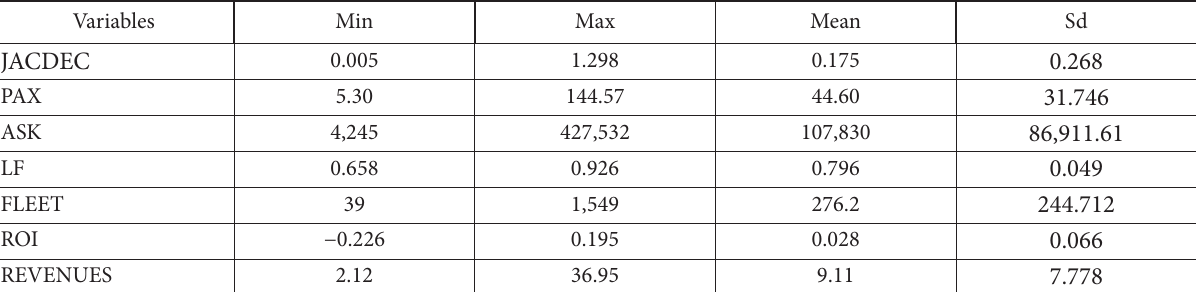
Table 1. Descriptive statistics